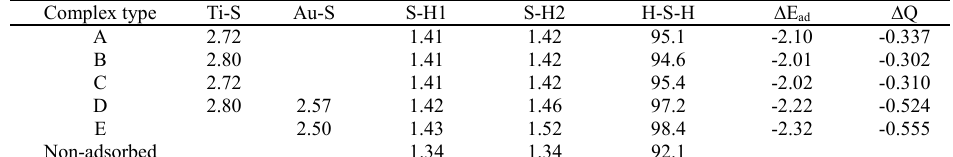
Table 1. Bond lengths (in Ǻ), bond angles (in degrees), adsorption energies (in eV), and Mulliken charge values of H 2 S molecule adsorbed on the TiO 2 /Au nanocomposites.